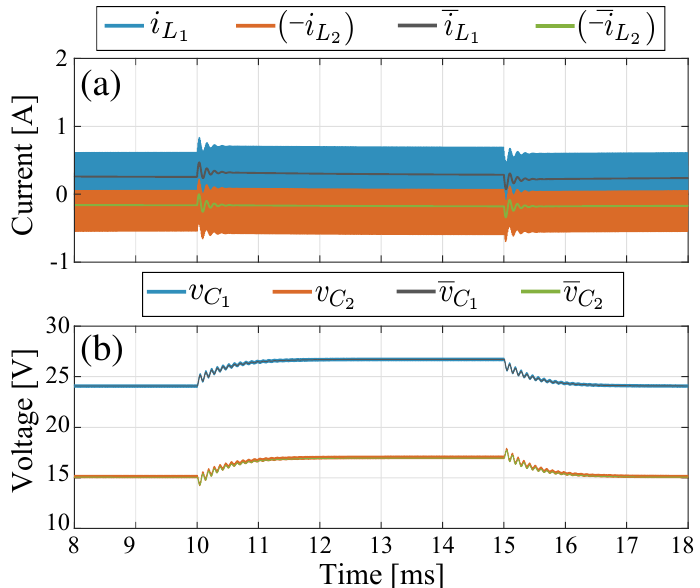
Figure 6. Comparison results in ´Cuk converter without coupled inductors: ( a ) inductor currents, ( b ) capacitor voltages. Table 5. Theoretical transfer functions of the ´Cuk converter under the tests conditions depicted in Table 3.